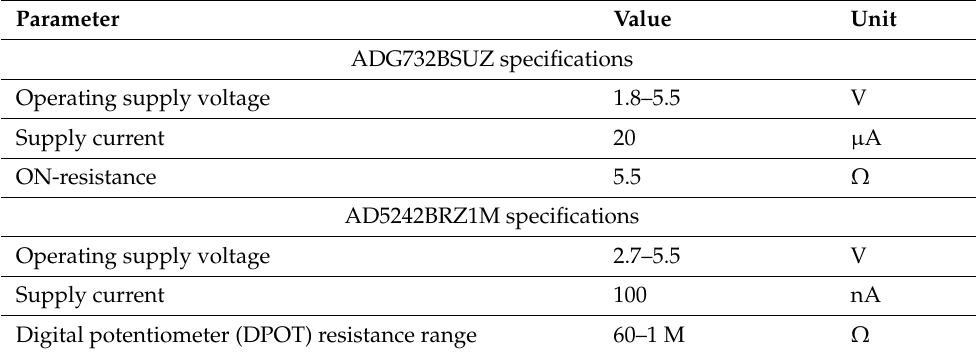
Table 2. Component specifications considered for the top and bottom PCBs